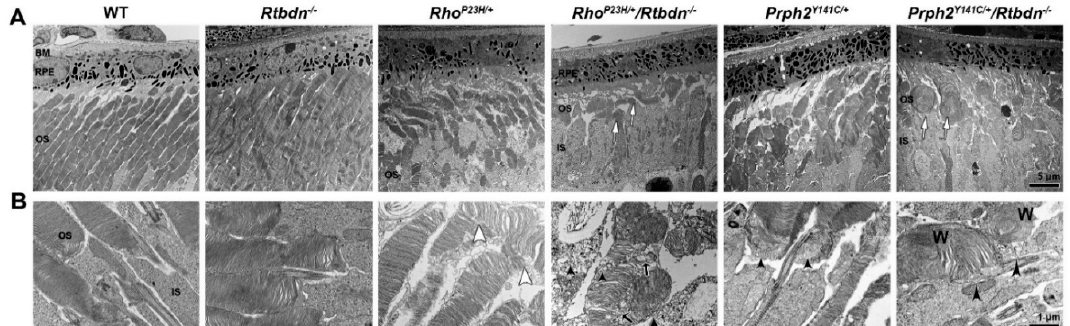
Figure 5. Ultrastructural effect of Rtbdn ablation in degenerating retinas. ( A , B ) Shown are representative TEM images of the outer retina/RPE ( A ) and the OS ( B ) from the indicated genotypes at P30. White arrows show short, sparse OSs, white arrowheads heads show mis-oriented OS discs, black arrows show unflattened discs, and black arrowheads show abnormal membrane accumulation; “W” indicates whorls. Magnification; 5000× ( A ), 25,000× ( B ). Scale bar 5 μ m ( A ), 1 μ m ( B ). BM; Bruch’s membrane, RPE; retinal pigment epithelium, OS; outer segment, IS; inner segment. EM images were captured from at least three eyes/genotype.